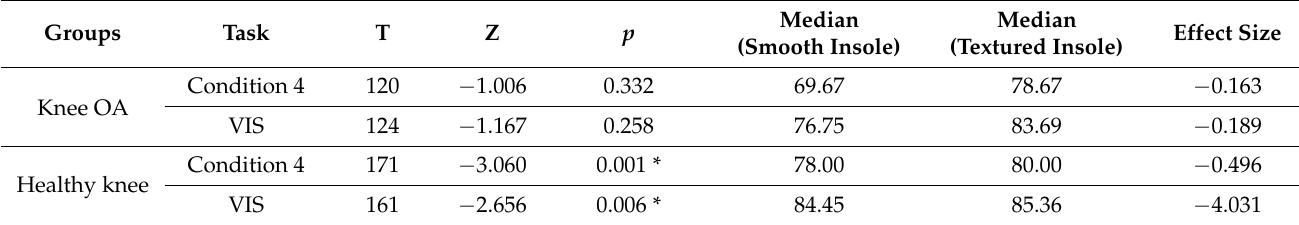
Table A5. Wilcoxon signed-ranks tests results. (Null hypothesis: there are no textured insole effects in the balance.)